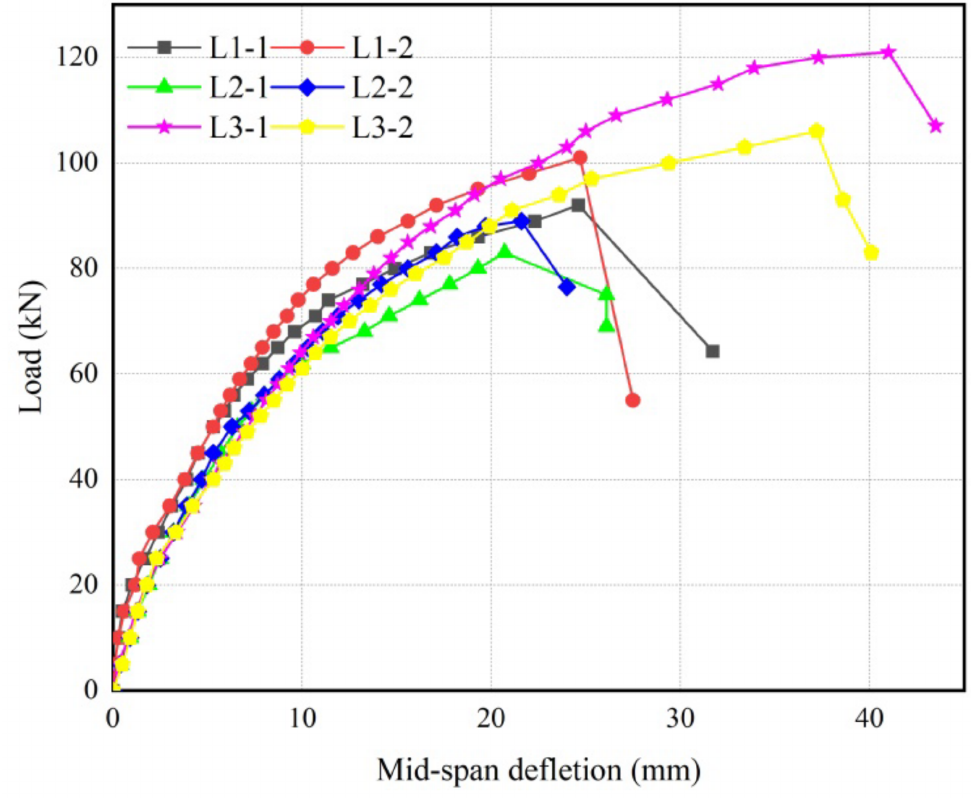
Figure 6. Load–span deflection